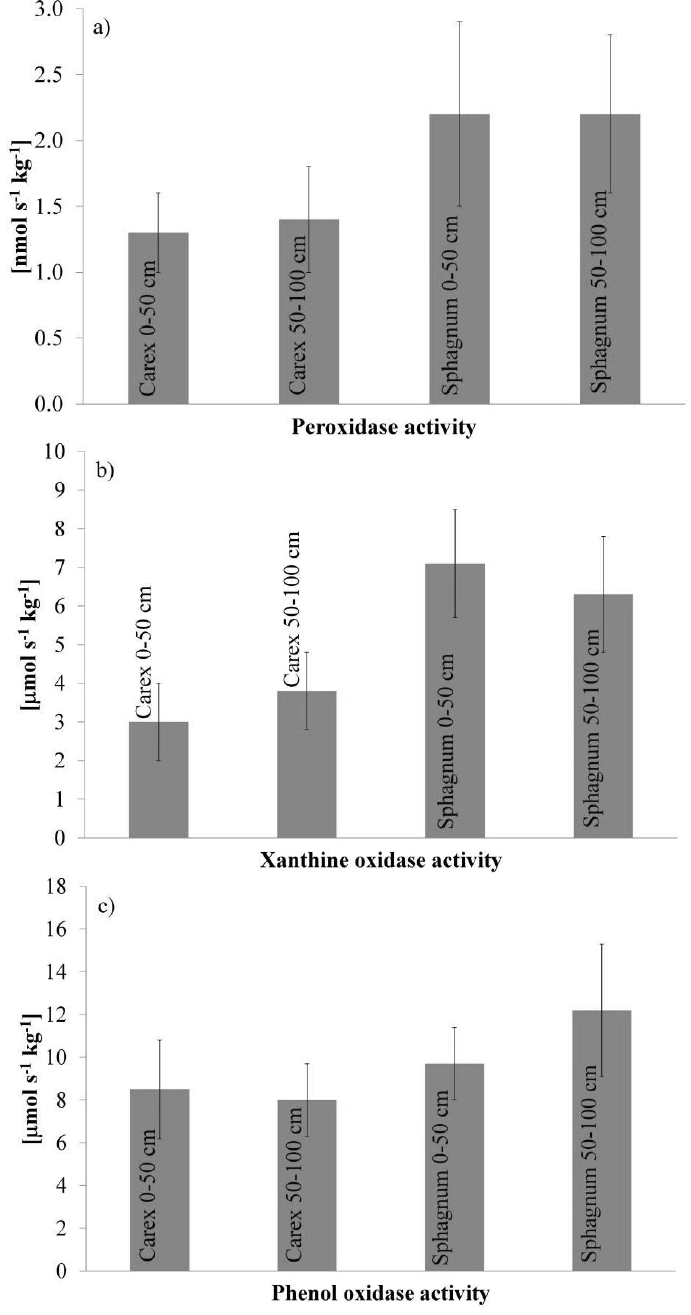
Figure 3. Enzymes participating in the oxidation processes in studied soils: a) peroxidase, b) xanthine oxidase, c) phenol